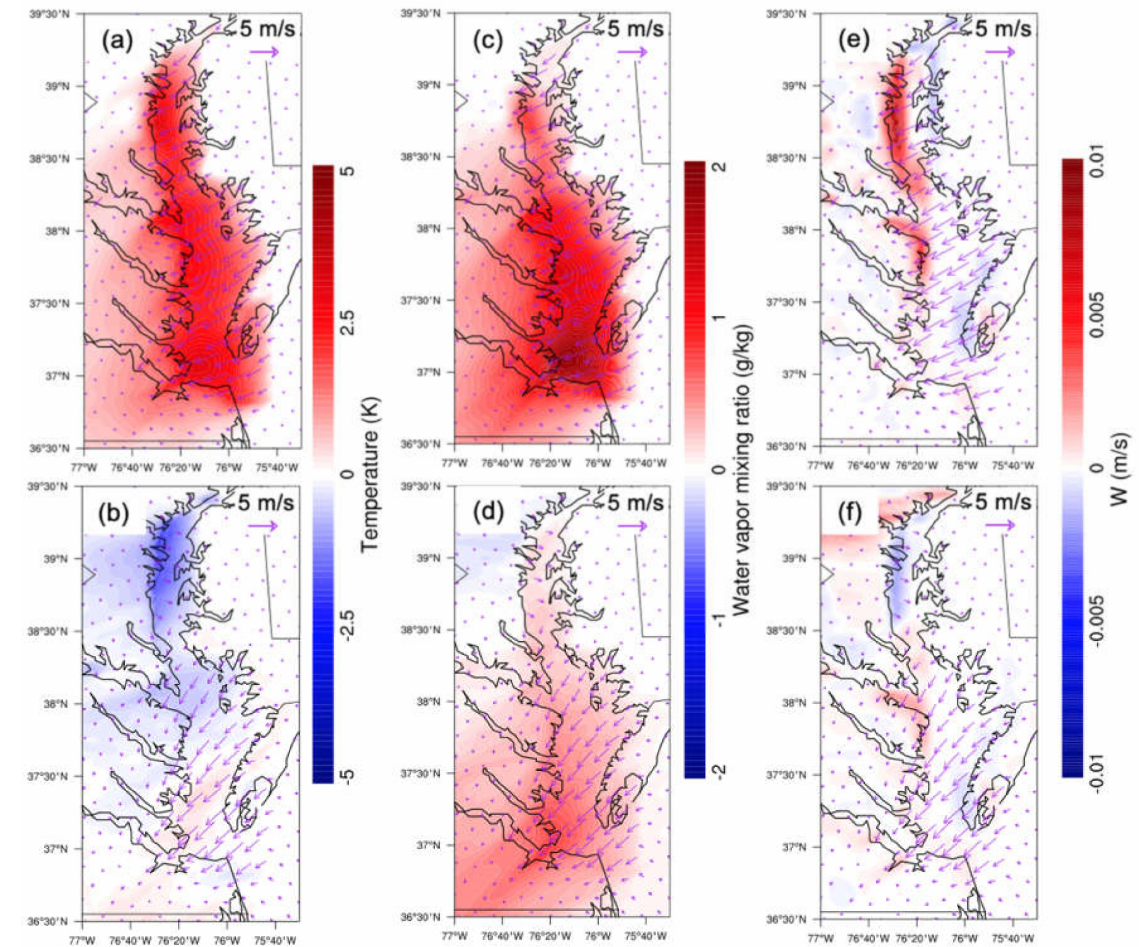
Figure 9. WRF–Chem-simulated absolute differences (water minus nowater) in temperature ( a , b ), water vapor mixing ratio ( c , d ), and vertical velocity ( e , f ) between simulations of baseline (water) and sensitivity (nowater) experiments over CB overlaid with corresponding surface wind differences. The first row is at night; the second row is in the day. Daytime is defined as 1000–0000 UTC (or 06:00–20:00 local time); nighttime is defined as 0000–0900 UTC (or 00:00–06:00 and 20:00–00:00 local time). Pressure differences were observed from the baseline and sensitivity experiments. At night, the effect of CB increased the surface pressure over the western shore of